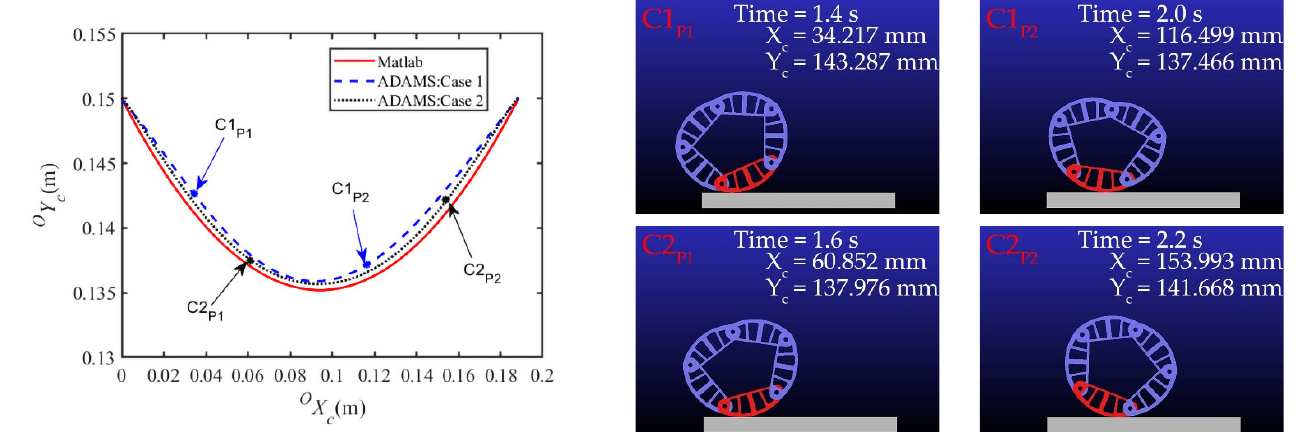
Figure 17. Theoretical and simulated trajectories of the CoM at h = 0.120 m.